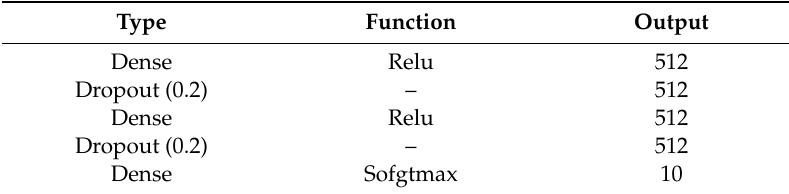
Table 5. Multilayer perceptron (MLP) architecture.